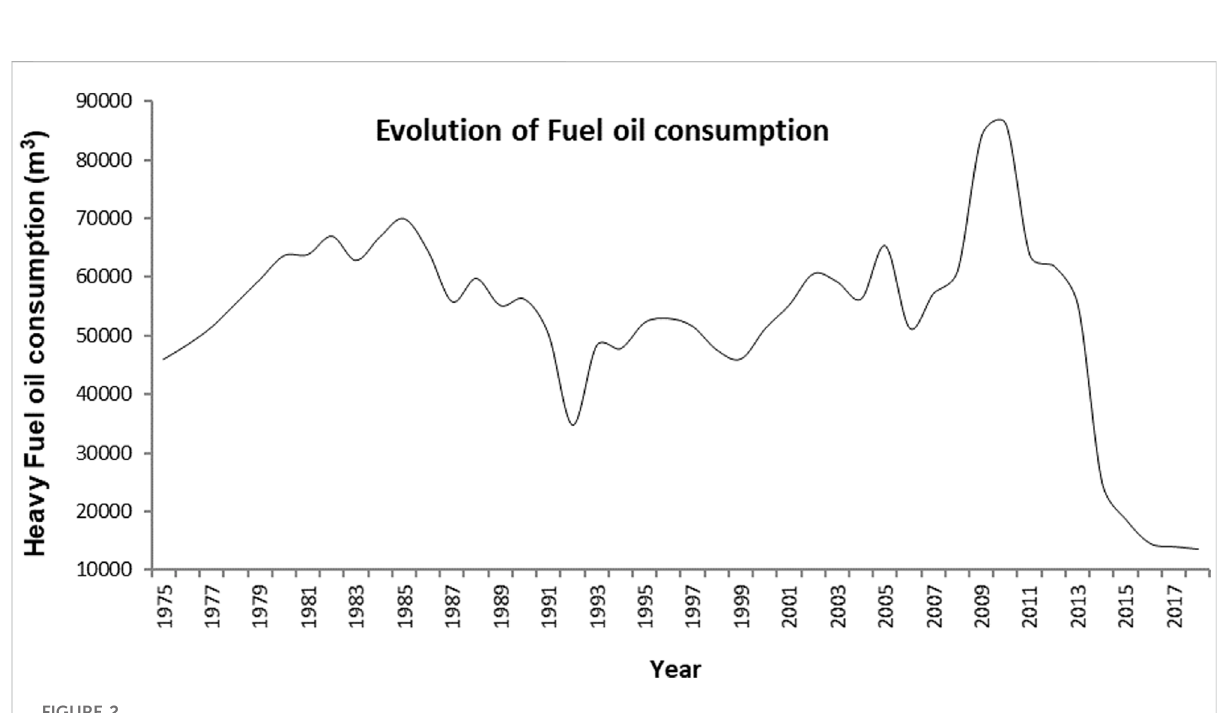
FIGURE 2 Evolution of fuel oil consumption (Victoria Oil & Gas,